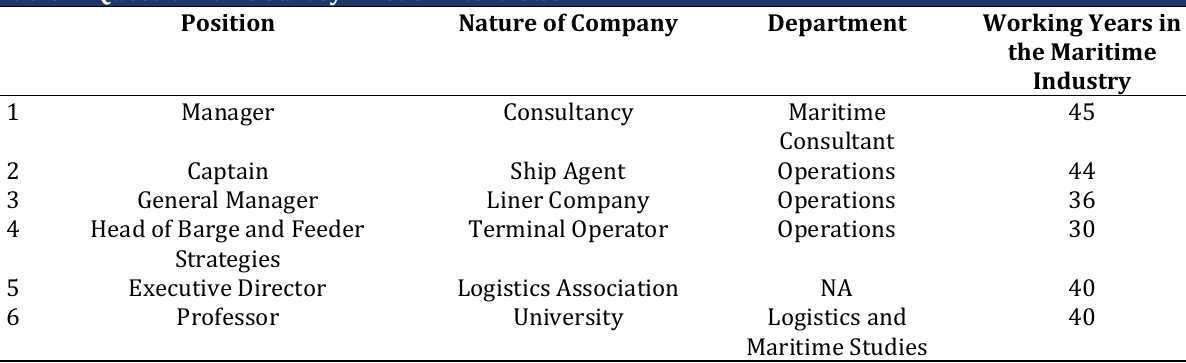
Table 2: Questionnaire Survey - List of